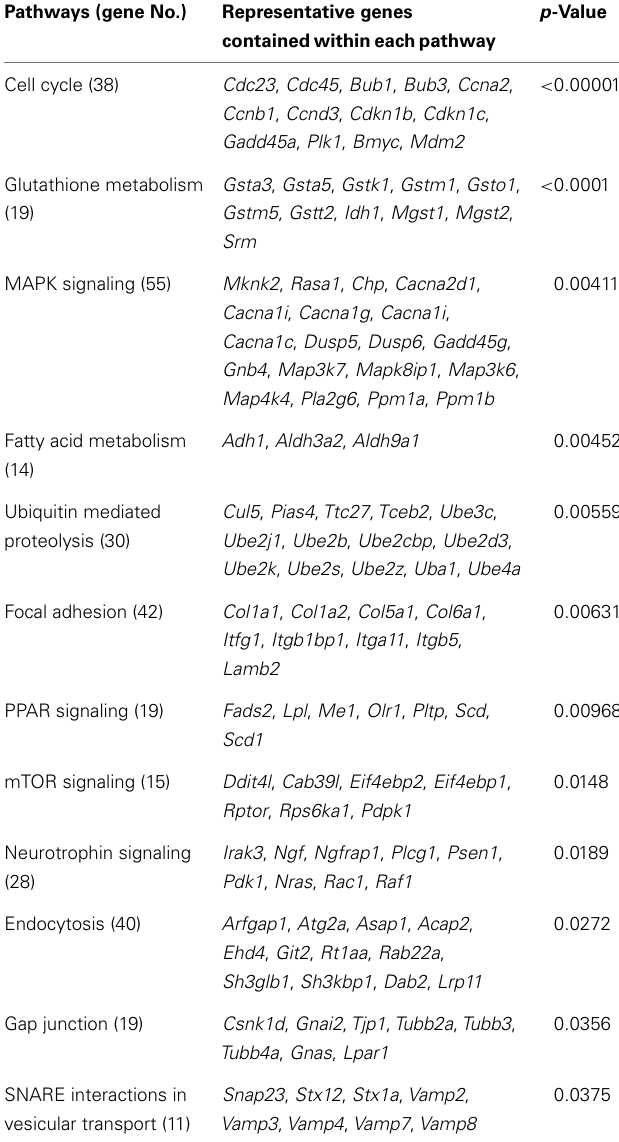
Table 5 | Pathway analysis of DNA microarray using DAVID online annotation